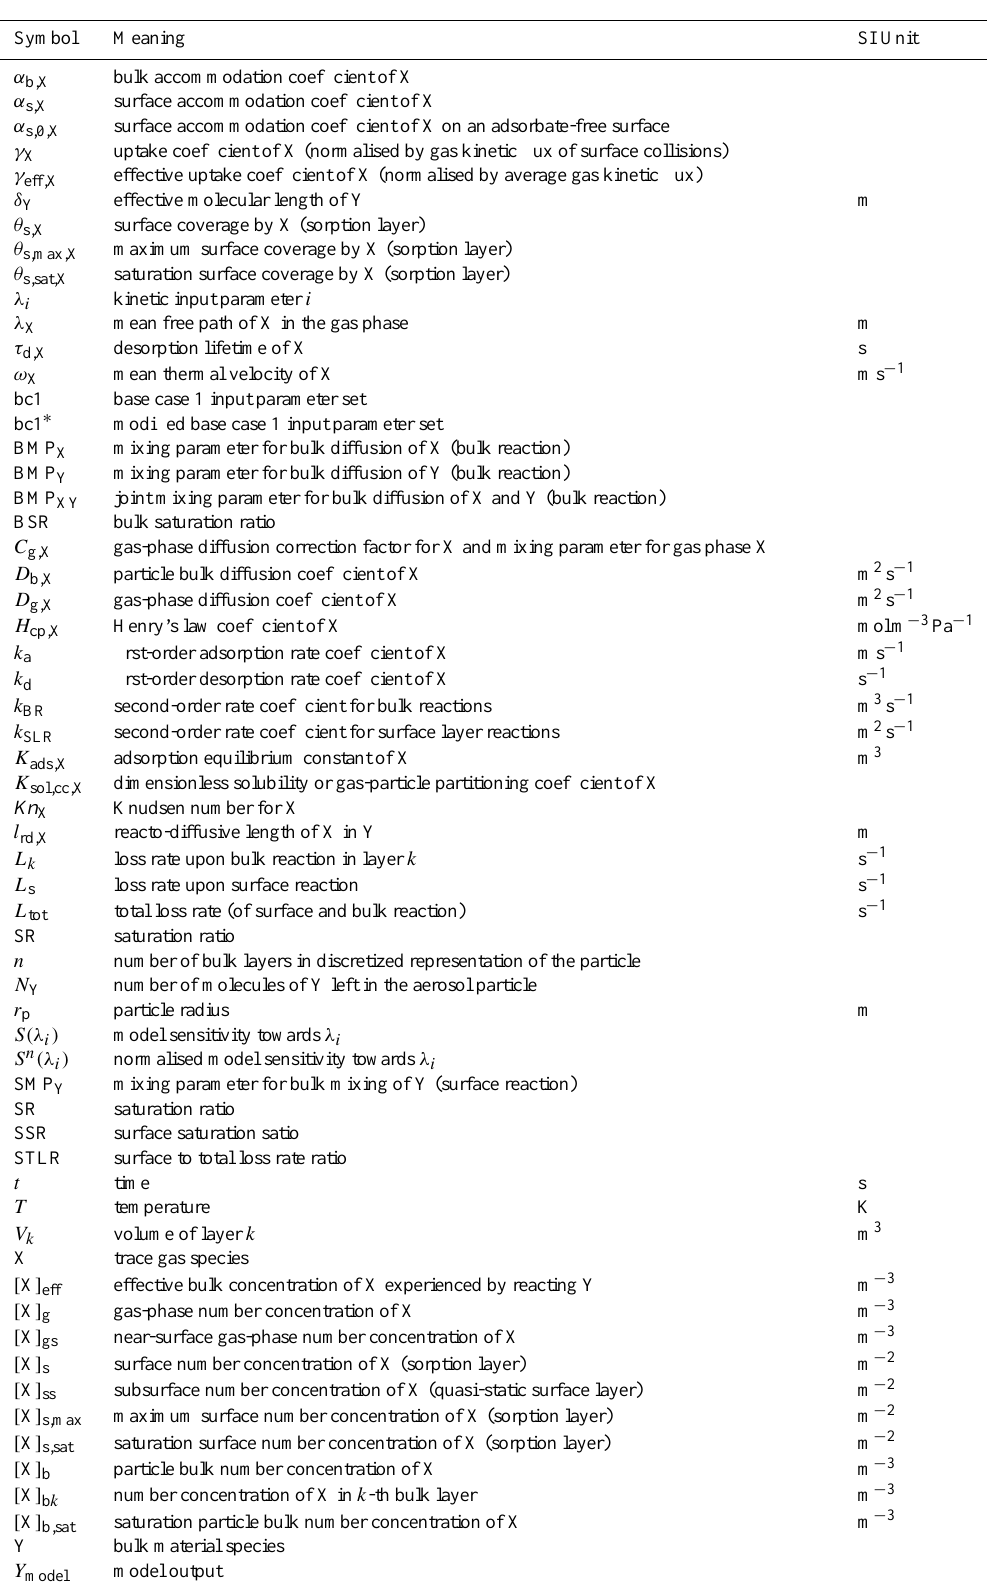
Table A1. List of symbols and